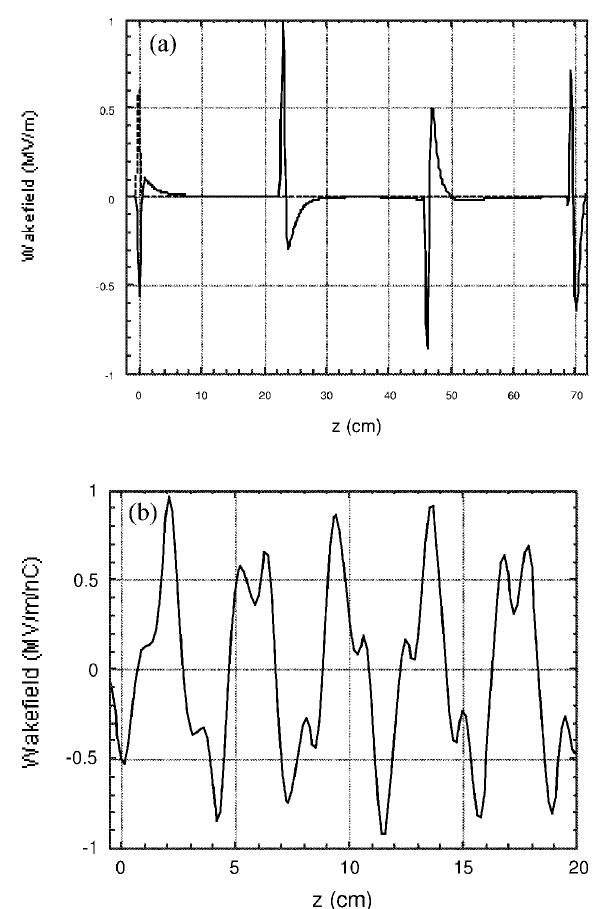
FIG. 2. (a) Longitudinal wakefield (solid line) from a single drive bunch (dashed line) located at z (cid:1) 0 cm with bunch mov- ing from right to left in a multimode structure. Note the can- cellation of the wakefield between the peaks. (b) Longitudinal wakefield (solid line) from a single drive bunch (not shown) lo- cated at z (cid:1) 0 cm with bunch moving from right to left in a single-mode structure. The points are the value of the wakefield at each point, and the solid line is a fit to the fundamental TM 01